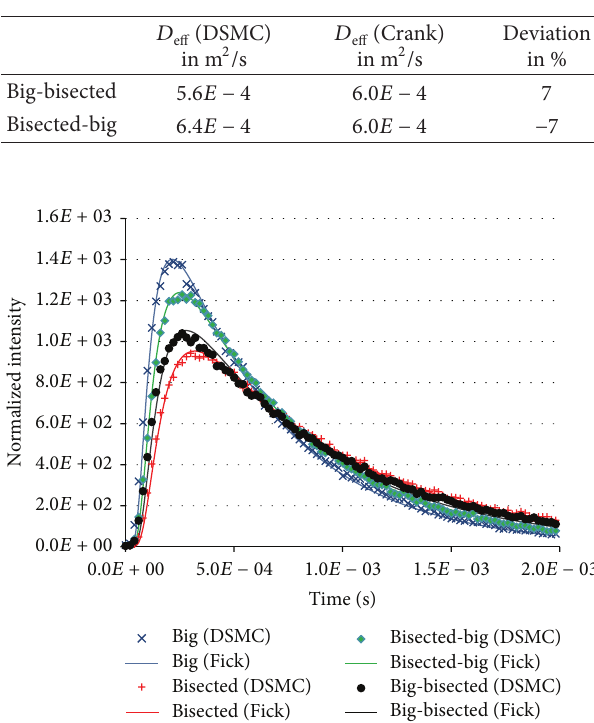
Table 2: Effective diffusion coefficients for geometries with inner walls [7].